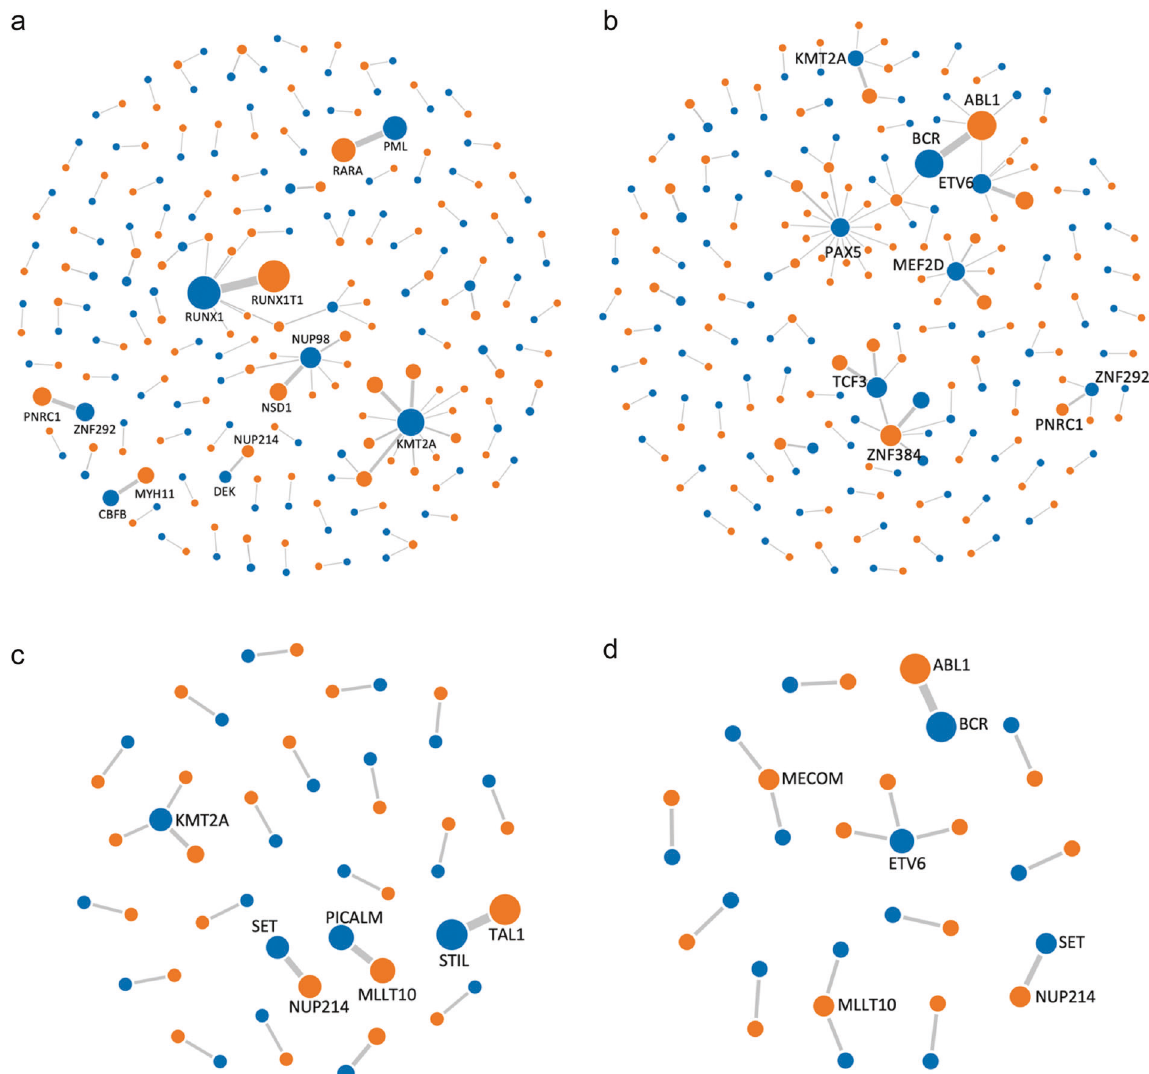
Fig. 2 Fusion gene networks in AML, B-ALL, T-ALL, and MPAL. a Fusion gene network in AML. b Fusion gene network in B-ALL. c Fusion gene network in T-ALL. d Fusion gene network in MPAL. The blue and orange nodes represent the 5 ′ fusion gene partner and the 3 ′ fusion gene partner, respectively. Lines represent fusions. The size of nodes and thickness of lines re fl ect the frequency of the observed fusions ( ETV6-ARNT , ETV6-NCOA2 , ETV6-LOH12CR1 ), 2 MLLT10 fusions ( PICALM-MLLT10 and NAP1L1-MLLT10 ), and 2 MECOM fusions ( RUNX1-MECOM and TRA2B-MECOM ) were detected in 1 case each. SET-NUP214 and KMT2A-MLLT4 were found in 2 cases and 1 case, respectively. KMT2A fusions KMT2A -FM is a large FG-FM that has been systematically studied and reported in acute leukemia, with more than 100 partner genes, and their speci fi c breakpoint regions have been identi fi ed [18, 19]. In this study, fusions of KMT2A with 14 different partner genes were detected in 76 cases (7.6%), including a novel KMT2A- CARS fusion identi fi ed in a pediatric T-ALL case (Fig. S1). KMT2A-MLLT4 was the most recurrent, with a frequency of 1.9%, followed by KMT2A-MLLT3 (1.4%), KMT2A-MLLT10 (1.2%), and KMT2A-AFF1 (1.1%). The incidences of KMT2A-MLLT1 (0.6%), KMT2A-ELL (0.4%), KMT2A-MLLT6 (0.2%), and KMT2A-USP2 (0.2%) were all below 1%. Besides, one case each with KMT2A-MAML2 , KMT2A-MLLT11 , KMT2A-MYO1F , KMT2A-SEPT5 , KMT2A-SEPT6 , and KMT2A-CARS were identi fi ed (Table S5).